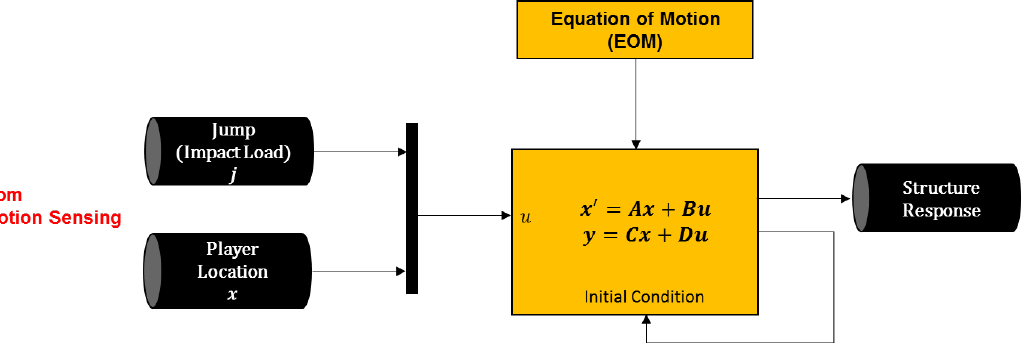
Figure 7. Overview of the structural dynamic analysis.